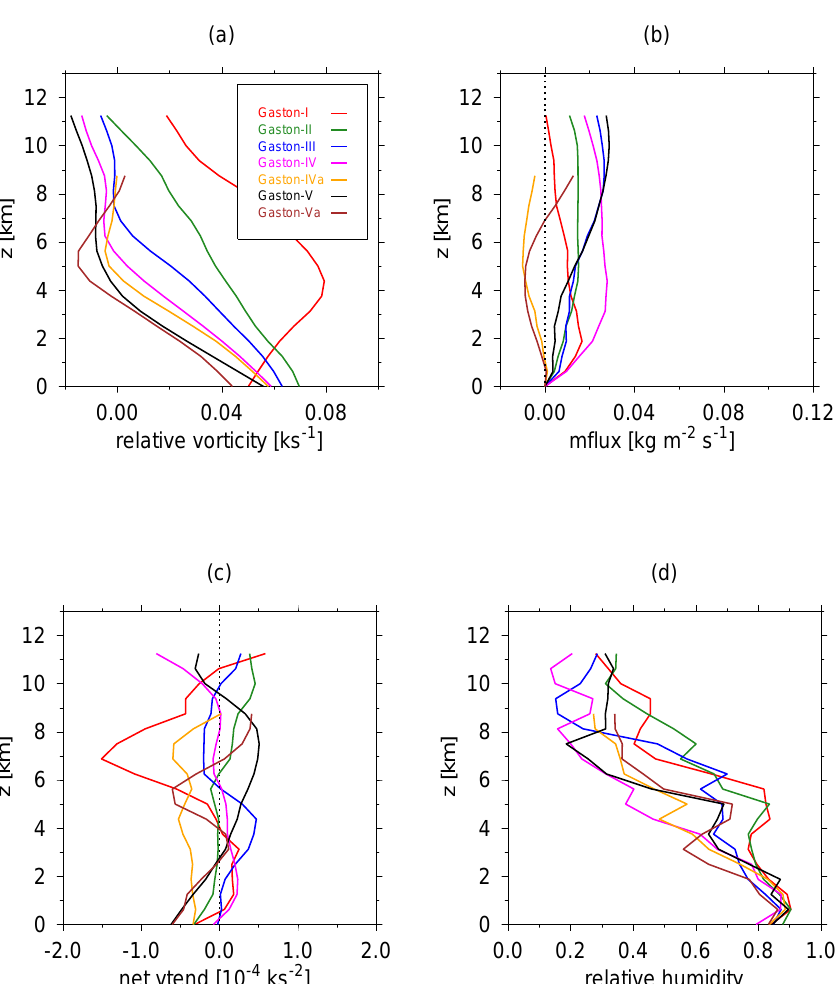
Fig. 4. Karl (left column) and Gaston (right column). The upper panels show the time series of the instability index. The solid circles in the lower panels are for the mid-level relative vorticity and the diamonds are for the low-level relative vorticity.